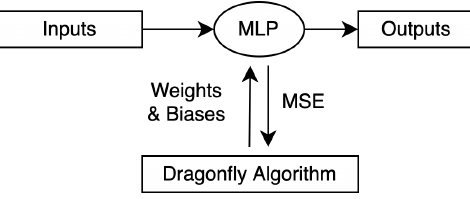
Figure 9. Training of MLP using DA